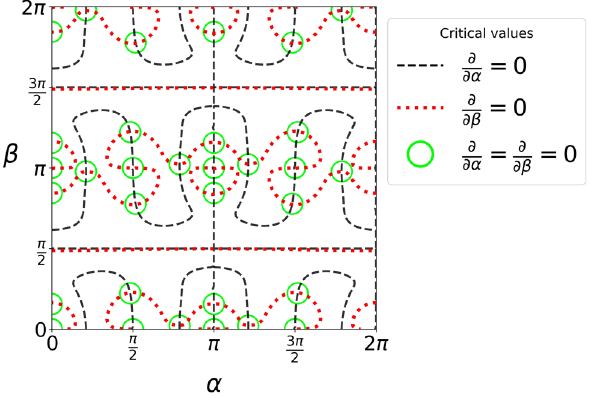
Figure 7: Contour lines for the partial derivatives of equation ( 19 ) .